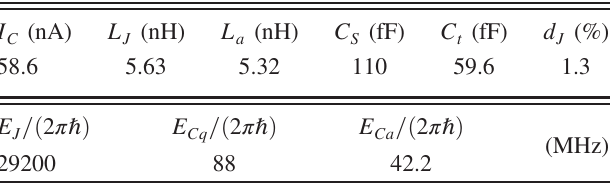
TABLE V. Circuit parameters at zero flux Φ ¼ 0 and T ¼ 20 mK.